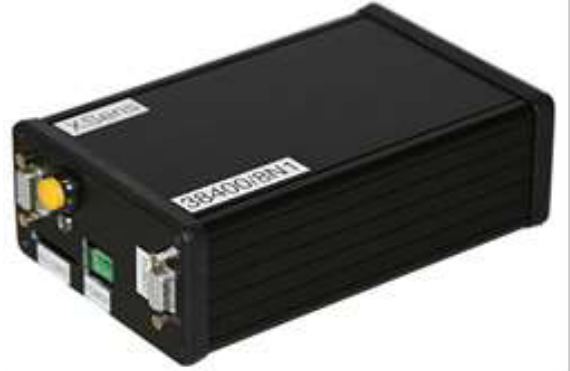
Figure. 3 Light weight data acquisition system.